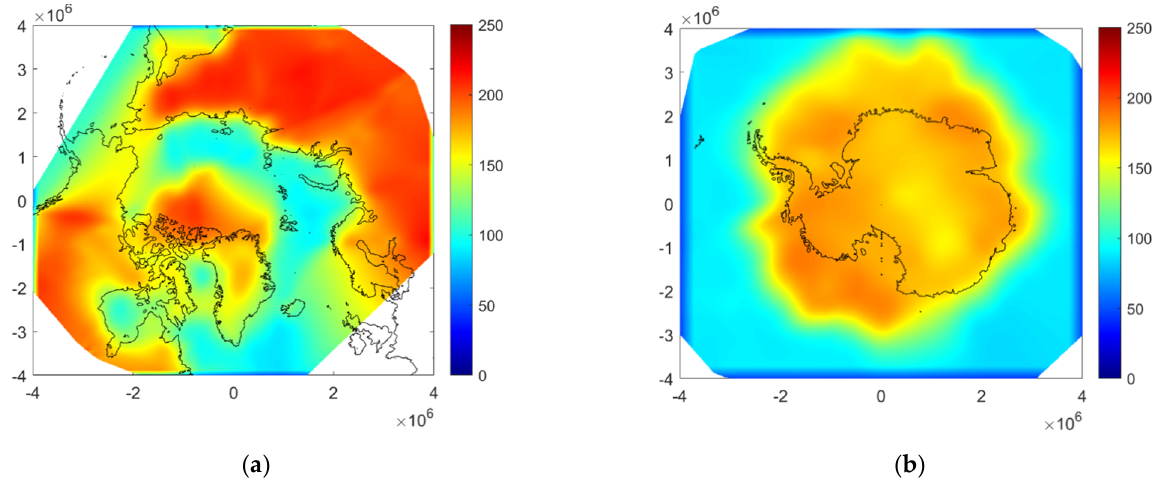
Figure 1. FFSCat brightness temperature (K) maps: ( a ) Arctic, October 7; and ( b ) Antarctic, 13 November to 15 November.